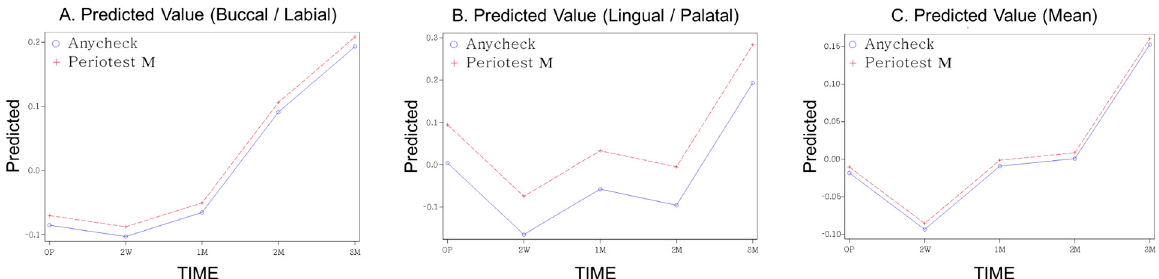
Figure 4. The predicted value over time (Z-score standardized, ( A ) buccal, ( B ) lingual, ( C ) mean).